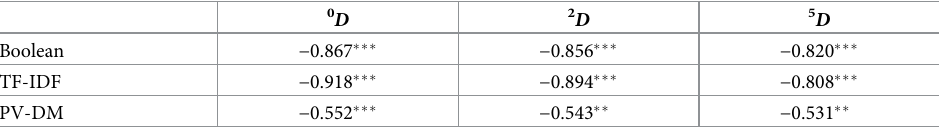
Table 1. Correlation coefficients of diversity q D with year and significance levels ( �� : p-value � 0.05, ��� : p- value �